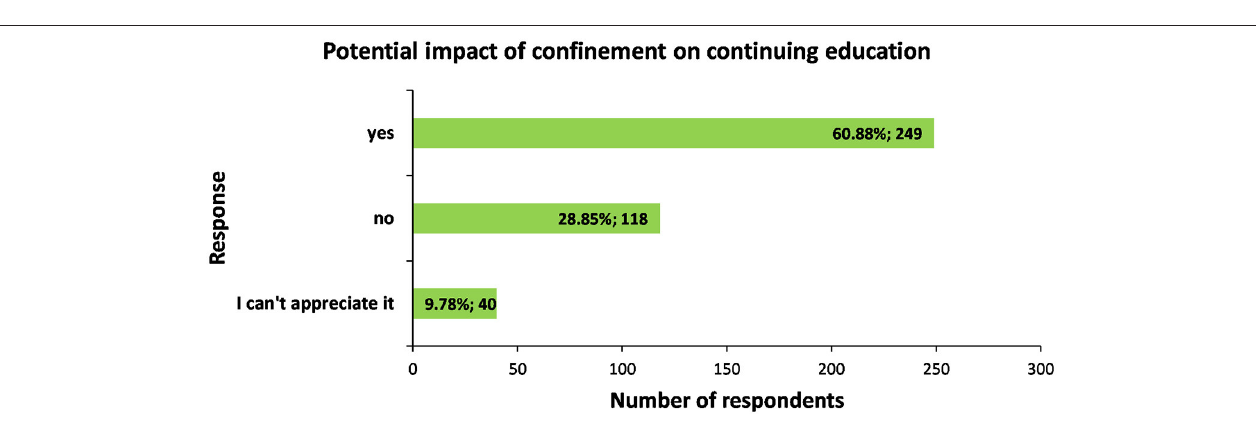
FIGURE 3 | Distribution of respondents ( n = 407) with respect to their perception about the potential impact of confinement on their continuing